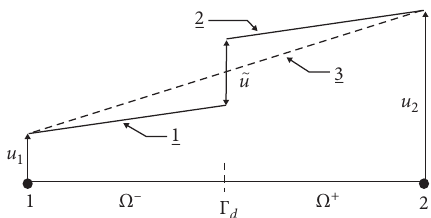
Figure 5: One-dimensional finite element with a